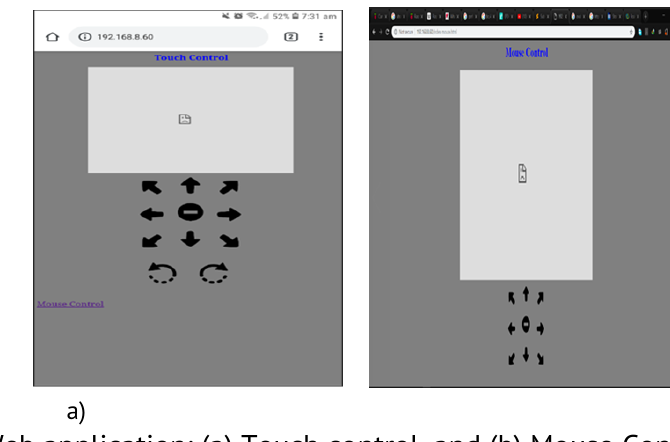
Figure 8. Web application: (a) Touch control, and (b) Mouse Control.